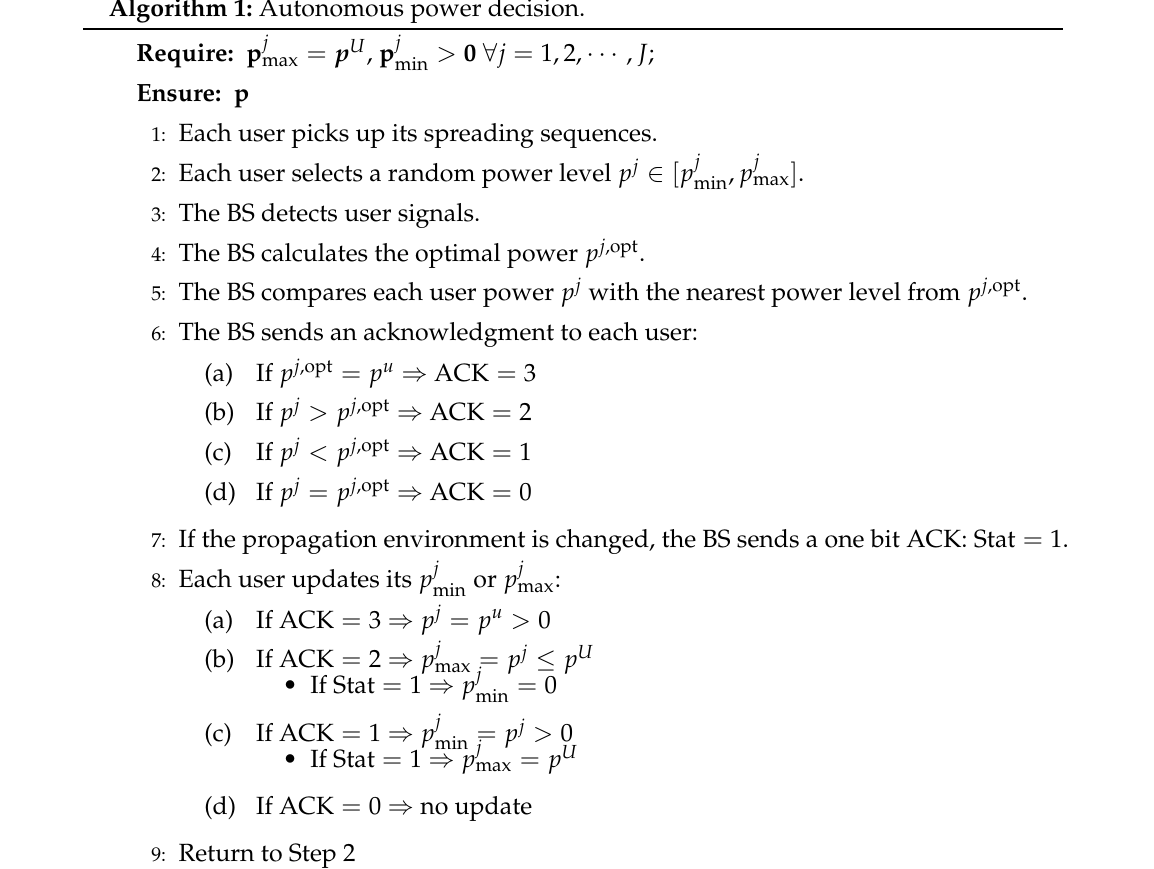
Algorithm 1: Autonomous power